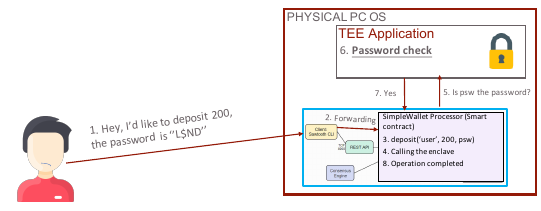
Figure 7. Password verification